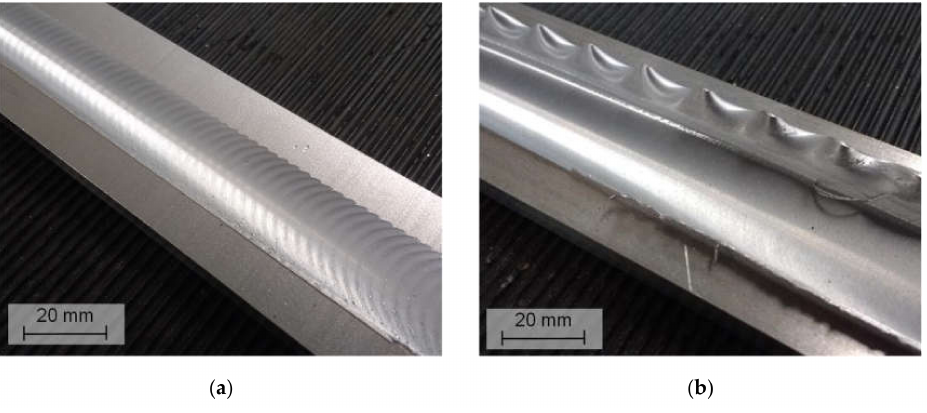
Figure 7. Welds with the parameter setting from experiment no. 14 with ( a ) and without ( b ) temperature